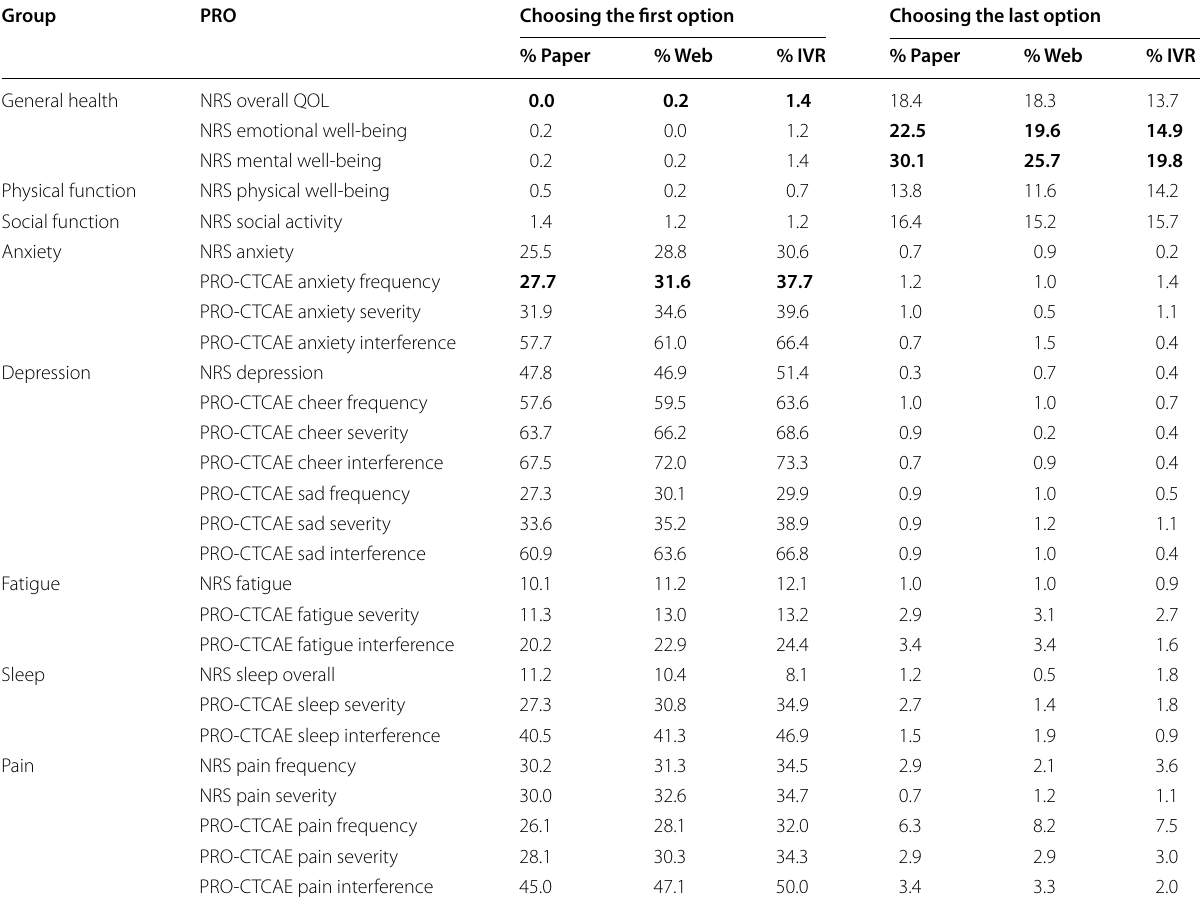
The comparisons with statistically significant differences in percentages after Bonferroni correction are